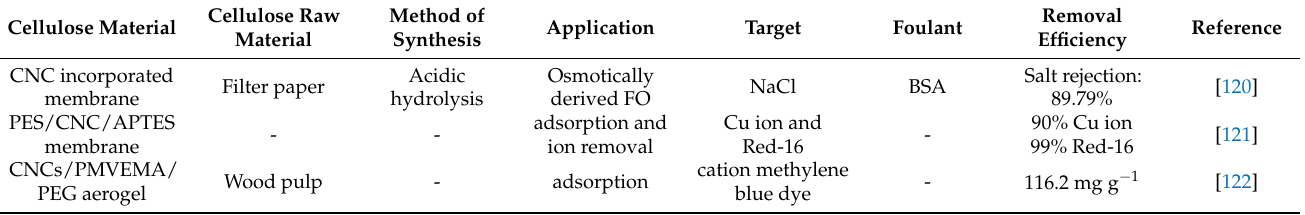
Table 2. The overview of the studies carried out using CNC-based membranes for the desalination and water treatment